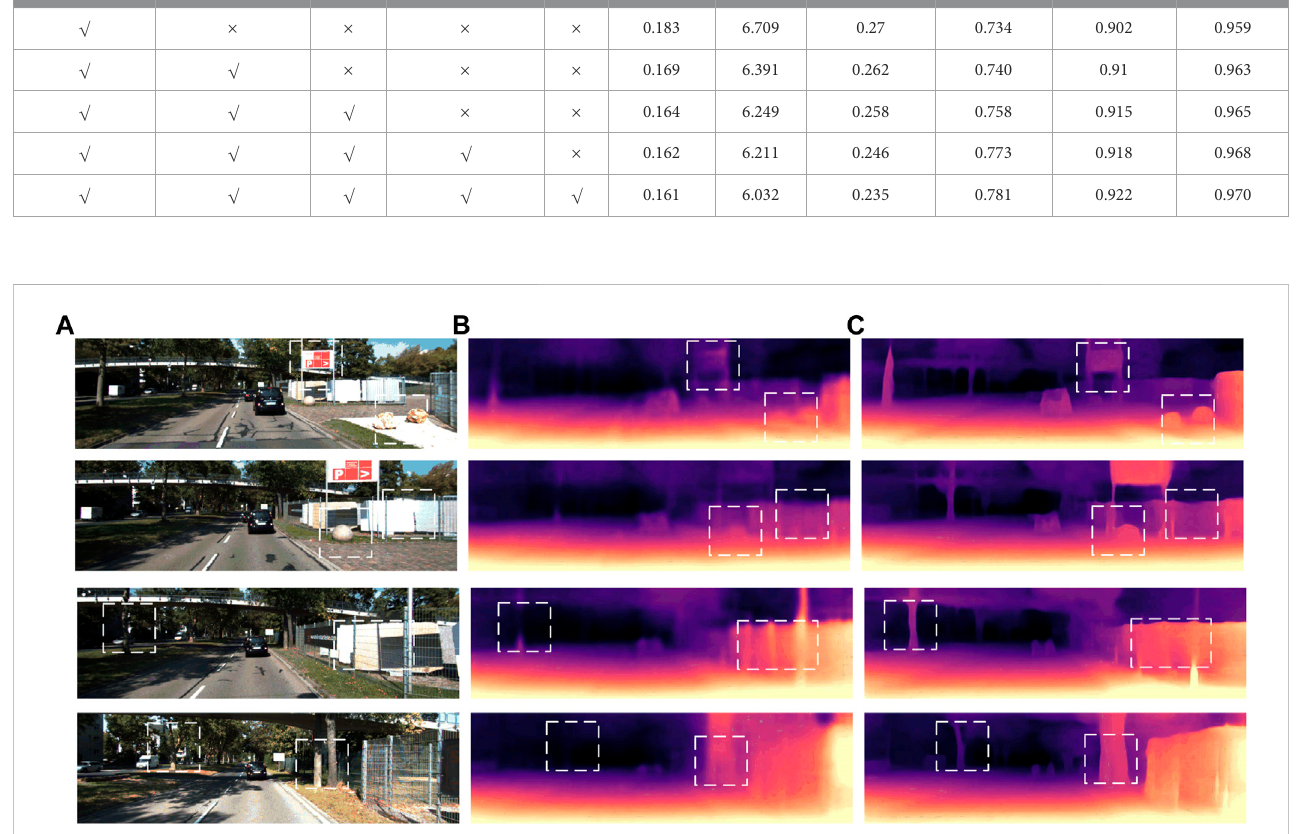
FIGURE 9 Comparative experimental results of asymmetric convolution module visualization on KITTI dataset: (A) represents the color image input by the model; (B) represents the depth map result predicted by Zhou et al.; (C) The ACResNet50 prediction of asymmetric convolution to the depth map